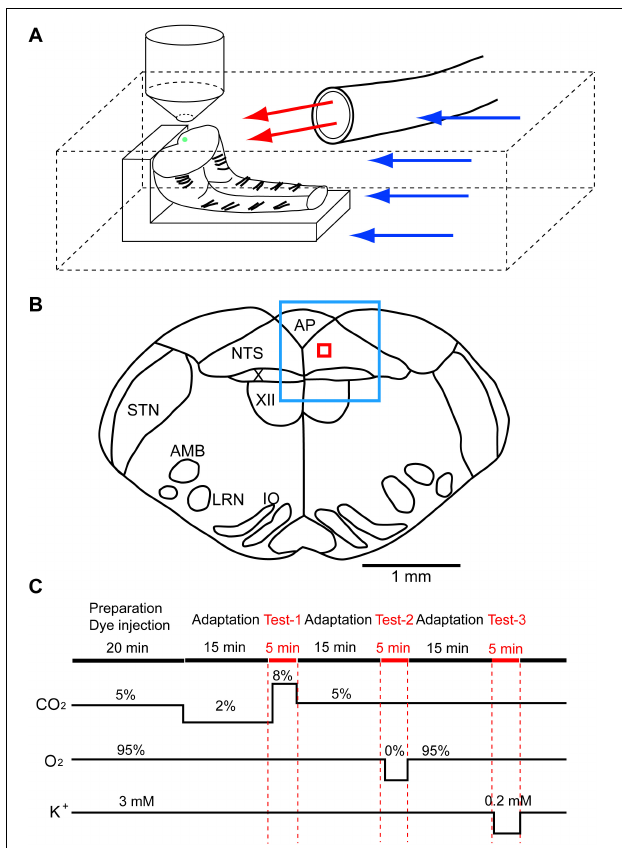
FIGURE 1 | Setup of preparation and rapid exchange system of superfusate and an approximate region of fluorescence recording. (A) The preparation (in this case, caudal block) was set on silicon rubber with the cut surface facing up. Artificial cerebrospinal fluid was superfused through two lines, (1) a main route perfusing the experimental chamber (blue arrows) and (2) a sub-route (red arrows) through a glass tube (inside diameter, 2 mm) that was placed close to the preparation. Under the control condition, the control solution was perfused through both routes. The test solution was applied to the preparation via the sub-route by replacing the control solution with the test solution. This system allowed rapid exchange (within 30 s) of the test solution. The green dot on the cut surface denotes an approximate injection area of the calcium indicator Oregon Green. (B) A typical cut surface of the medulla and an approximate region of the recording. The blue square denotes the focused area at low magnification (4 × ), and the red square denotes the recording area of fluorescence intensity at high magnification (40 × ). AMB, nucleus ambiguus; AP, area postrema; IO, inferior olivary nucleus; LRN, lateral reticular nucleus; NTS, nucleus of the tractus solitarius; STN, spinal trigeminal nucleus; X, dorsal motor nucleus of the vagus; XII, hypoglossal nucleus. (C) Protocol of experiments. Red marks denote periods of calcium imagings: Test-1, hypercapnic stimulation; Test-2, hypoxic stimulation; Test-3, low K +